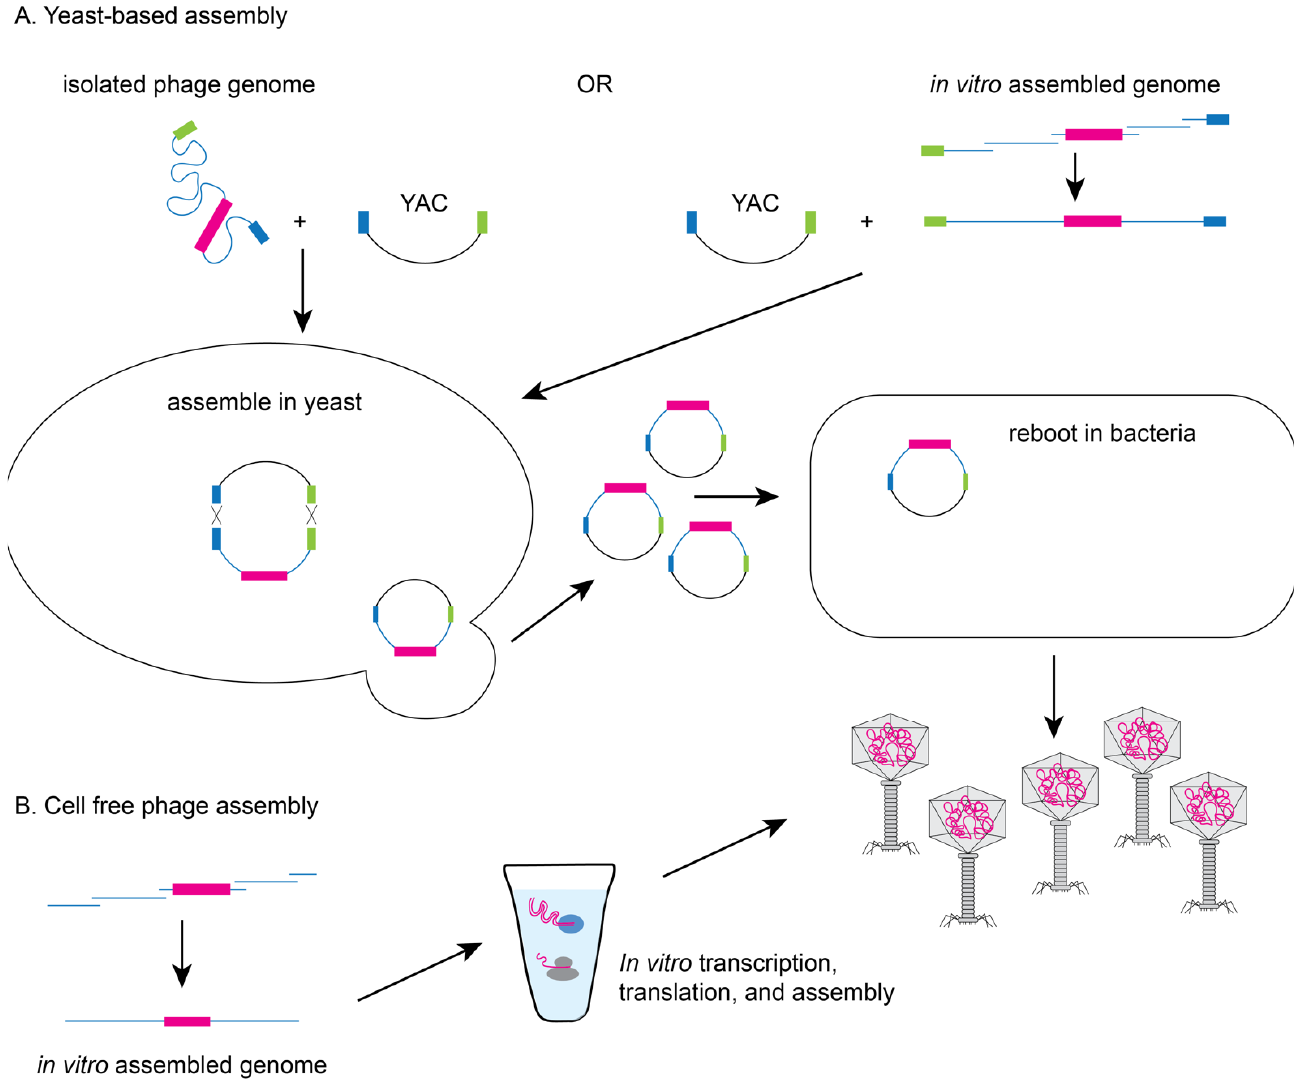
Figure 3. Yeast-based or cell-free phage assembly. ( A ) To avoid issues of toxicity with phage genes, modifications can be made to phage genomes in yeast using TAR based cloning. Phage genomes (isolated from a modified phage or assembled in vitro ) are electroporated into yeast with a linearized yeast artificial chromosome (YAC) containing hooks (blue and green boxes) to facilitate recombination. YACs containing the modified phage genomes can be electroporated into bacteria to produce recombinant phage particles. ( B ) Alternatively, phage particles can be produced from assembled recombinant phage genomes using cell-free transcription/translation systems.